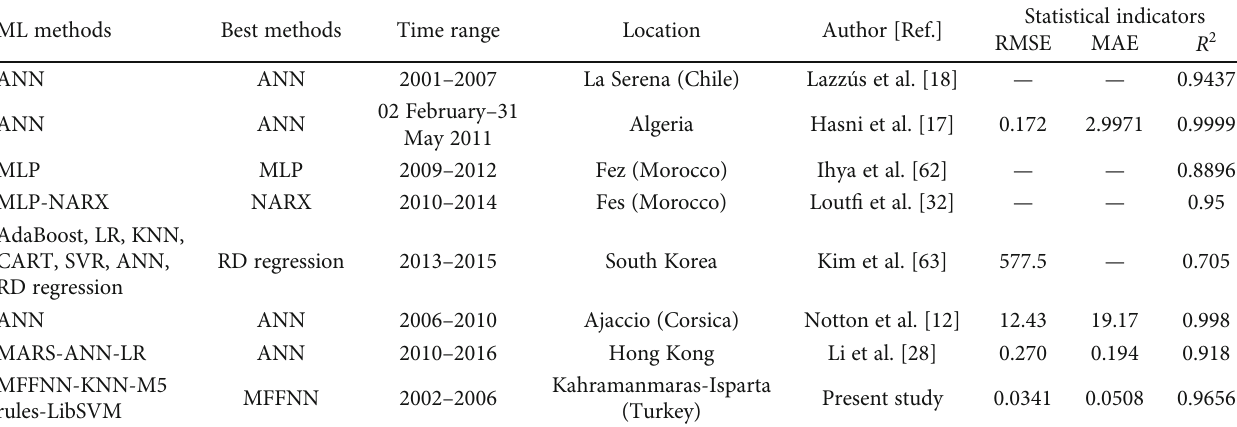
Table 13: Comparison of the performance of the present study with various HAGSR estimation models of the previous studies. ML